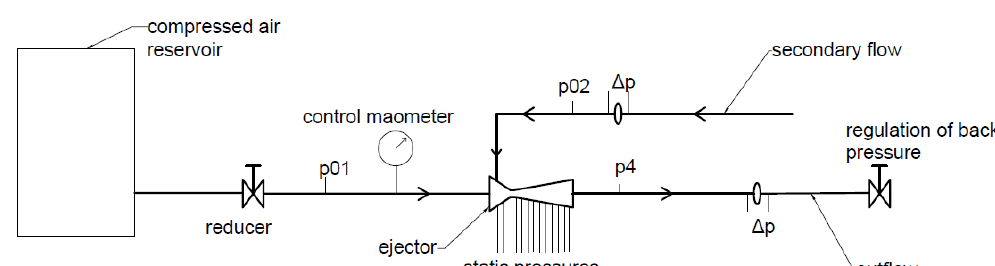
Fig. 5. Measurement schema of the ejector track